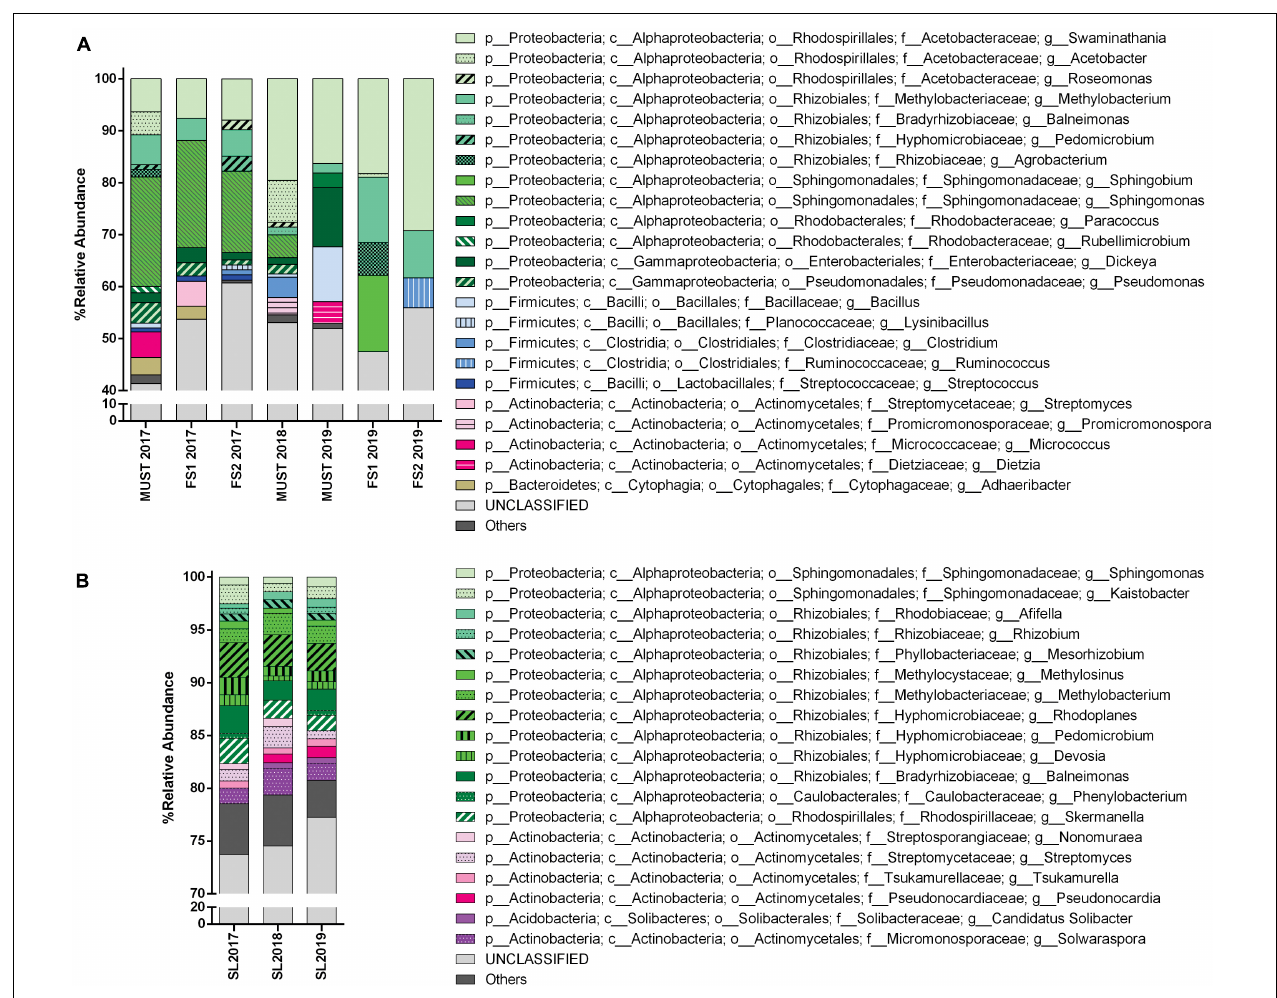
FIGURE 4 | Bacterial community structure from the Saldungaray vineyard for the years 2017, 2018, and 2019, at the genus level. Bacterial diversity of wine (A) and soil samples (B) . Only OTUs exhibiting a relative abundance ≥ 0.5% are shown. In addition, the “others” category includes minority ( < 0.5%)